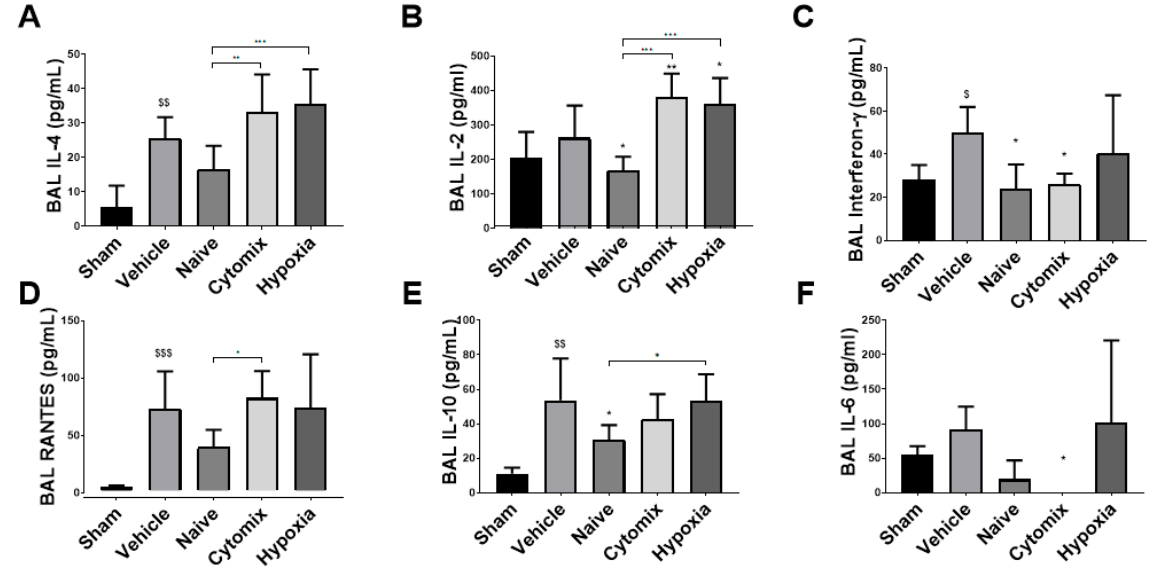
Figure 5. The T cell regulatory cytokines IL-4 and IL-2 were significantly decreased in the BAL with the administration of naïve MSCs and increased with the administration of cytomix- and hypoxia-pre-activated MSCs ( A , B ). IFN- γ was significantly reduced by both naïve and cytomix-pre-activated MSCs compared to the vehicle control ( C ). The chemotactic and leukocyte activation regulator RANTES was reduced by naïve MSC treatment compared to the vehicle ( D ), as was anti-inflammatory IL-10 ( E ) and inflammatory marker IL-6 ( F ). IL = interleukin; RANTES = regulated upon activation normal T cell expressed and presumably secreted. Columns represent means. Error bars represent SDs. **, *** = p ≤ 0.01, 0.001 with respect to the vehicle control. $$, $$$= p ≤ 0.05, 0.01, 0.001, 0.0001 with respect to the sham group. N = 8–12.